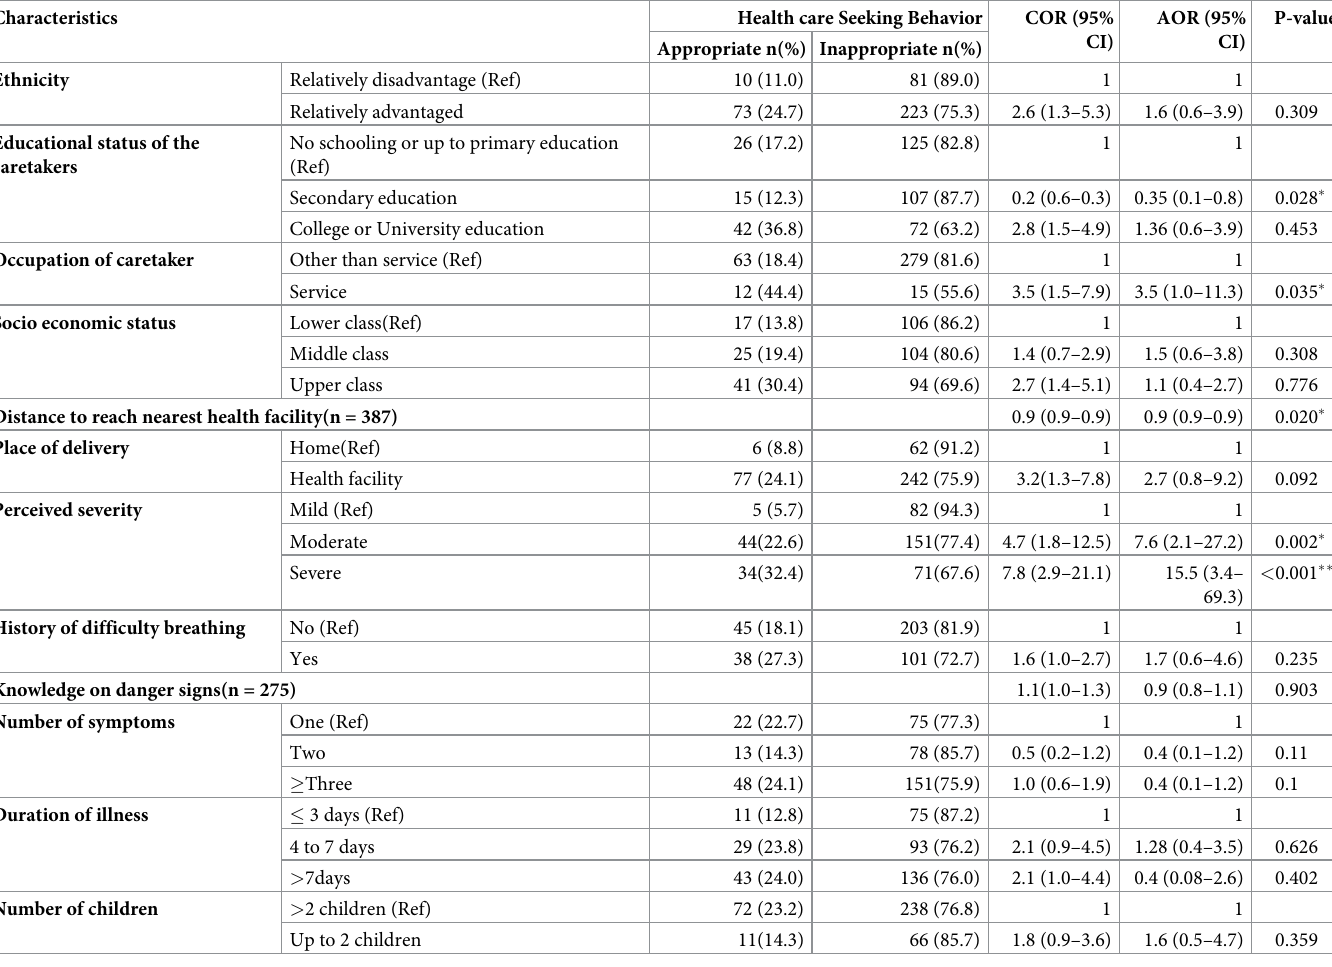
Table 5. Bivariate and multivariate association of different variables with health care seeking